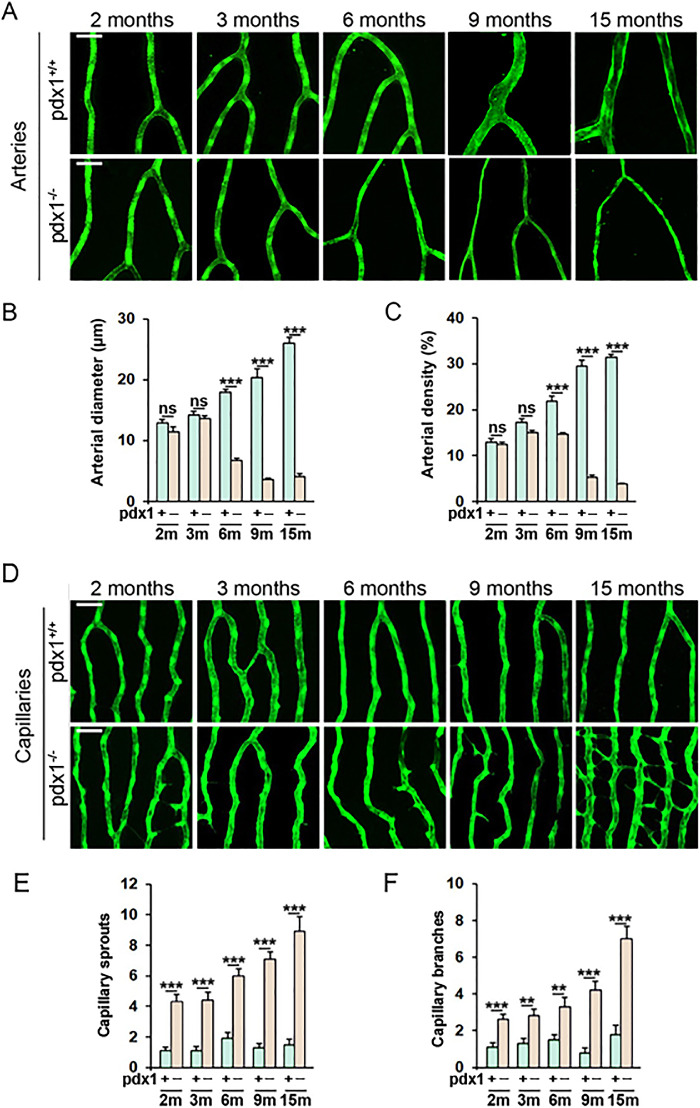
Vascular phenotypes progress over time. Retina flat mounts of pdx1−/− mutants and pdx1+/+ controls, transgenic for fli1a:EGFP, showing representative areas of arteries (A) and capillaries (D) at the ages indicated, from 2 months through 15 months of age. Size bars indicate 50 µm. (B, C) Quantitation of arterial diameter (B) and density (C) in 15 vessels or 15 regions respectively from 4 individual fish per group, from samples as shown in A. m, months, ns, not significant. ***P < 0.001. (E, F) Quantitation of the number of capillary sprouts (E) and branches (F) in 10 capillary regions from 3 individual fish per group, from samples as shown in D. p, pdx1, m, months. **P < 0.01, ***P < 0.001.